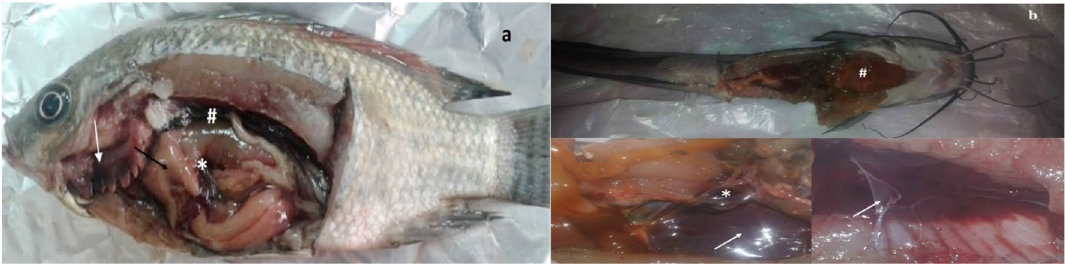
Figure 2. Post-mortem examination of naturally infected fish ( a ) Nile tilapia ( Oreochromis niloticus ) showing pale liver (black arrow), necrotic gills (white arrow), engorged spleen (*), serous fluid exudate, and congested kidney (#), ( b ) catfish ( Clarias gariepinus ) showing friable liver (#), congested kidneys (white arrows), and engorged spleen (*).